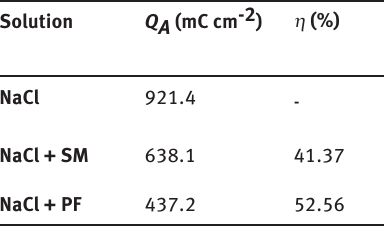
and inhibition efficiency, h for Fe Table 2: Anodic charge, Q A electrode in 0.1 mol L -1 NaCl containing SM extract and phenolic fraction (PF) of Satureja montana